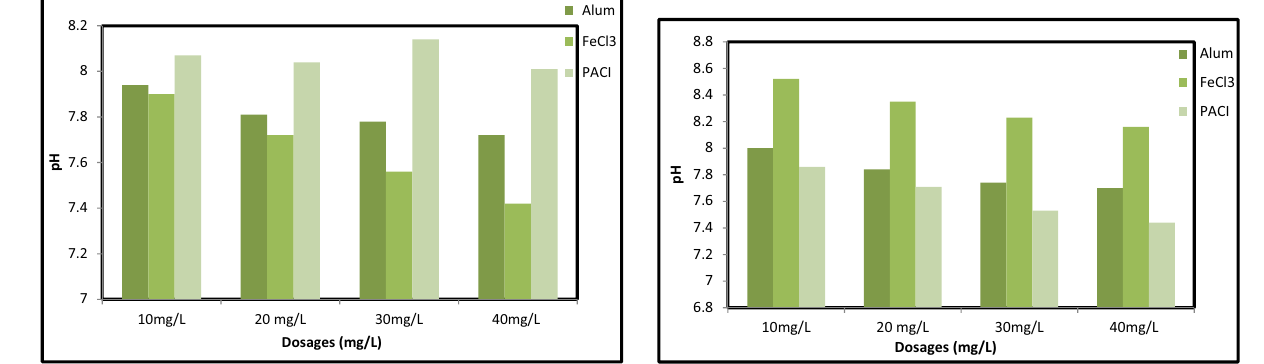
Figure 6: The relation between pH and dosages of coagulant for samples at 240 cm height.